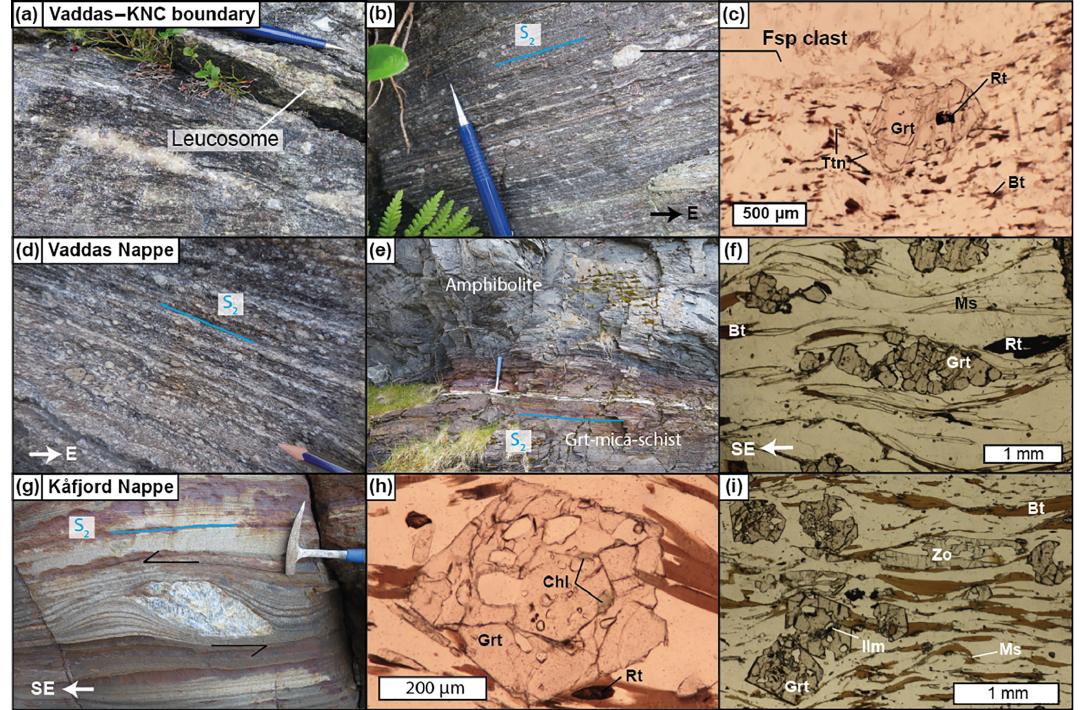
Figure 4. Field photographs and photomicrographs from Vaddas and Kåfjord nappes. Coordinates for sample sites are given in Table 1. (a) KNC paragneiss with visible (sheared) leucosome from 30m below the Vaddas–KNC boundary shear zone at site UL248. (b) The Vaddas–KNC boundary mylonite at site UL248. (c) Photomicrograph of sample UL248 showing the edge of a K-feldspar porphyroclast, garnet with a rutile inclusion, and matrix with biotite and titanite visible. (d) Sheared metaconglomerate from the base of the Vaddas Nappe on Uløya at lat 69.89326, long 20.55713 with mostly rounded quartzite clasts in a pelitic matrix of biotite and garnet. (e) Typical strongly sheared garnet-mica-schist and amphibolite sample in the Vaddas Nappe at lat 69.89326, long 20.55456 (Uløya). (f) Photomicrograph of Vaddas Nappe sample AR71 showing sheared garnet (top-to-SE shear sense), and muscovite fish, biotite, and rutile in the matrix. (g) An outcrop of a sheared calc-silicate lens (top-to-SE shear sense) in a typical garnet-zoisite-biotite schist from the lower Kåfjord Nappe at lat 69.85701, long 20.53317. (h) Photomicrograph of garnet in Kåfjord Nappe sample AR153 showing distinctive core and rim structure with chlorite inclusions in garnet cores and rutile in the matrix. (i) Photomicrograph of Kåfjord Nappe sample AR153 showing garnet porphyblasts in a matrix with S 2 foliation defined by zoisite, biotite, and muscovite. An ilmenite inclusion in garnet is also